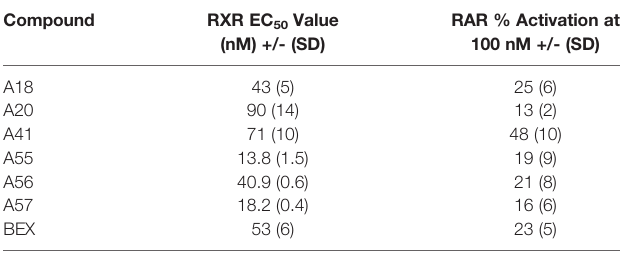
TABLE 1 | RXR EC 50 values in nM and % RAR activation at 100nM selected rexinoids.